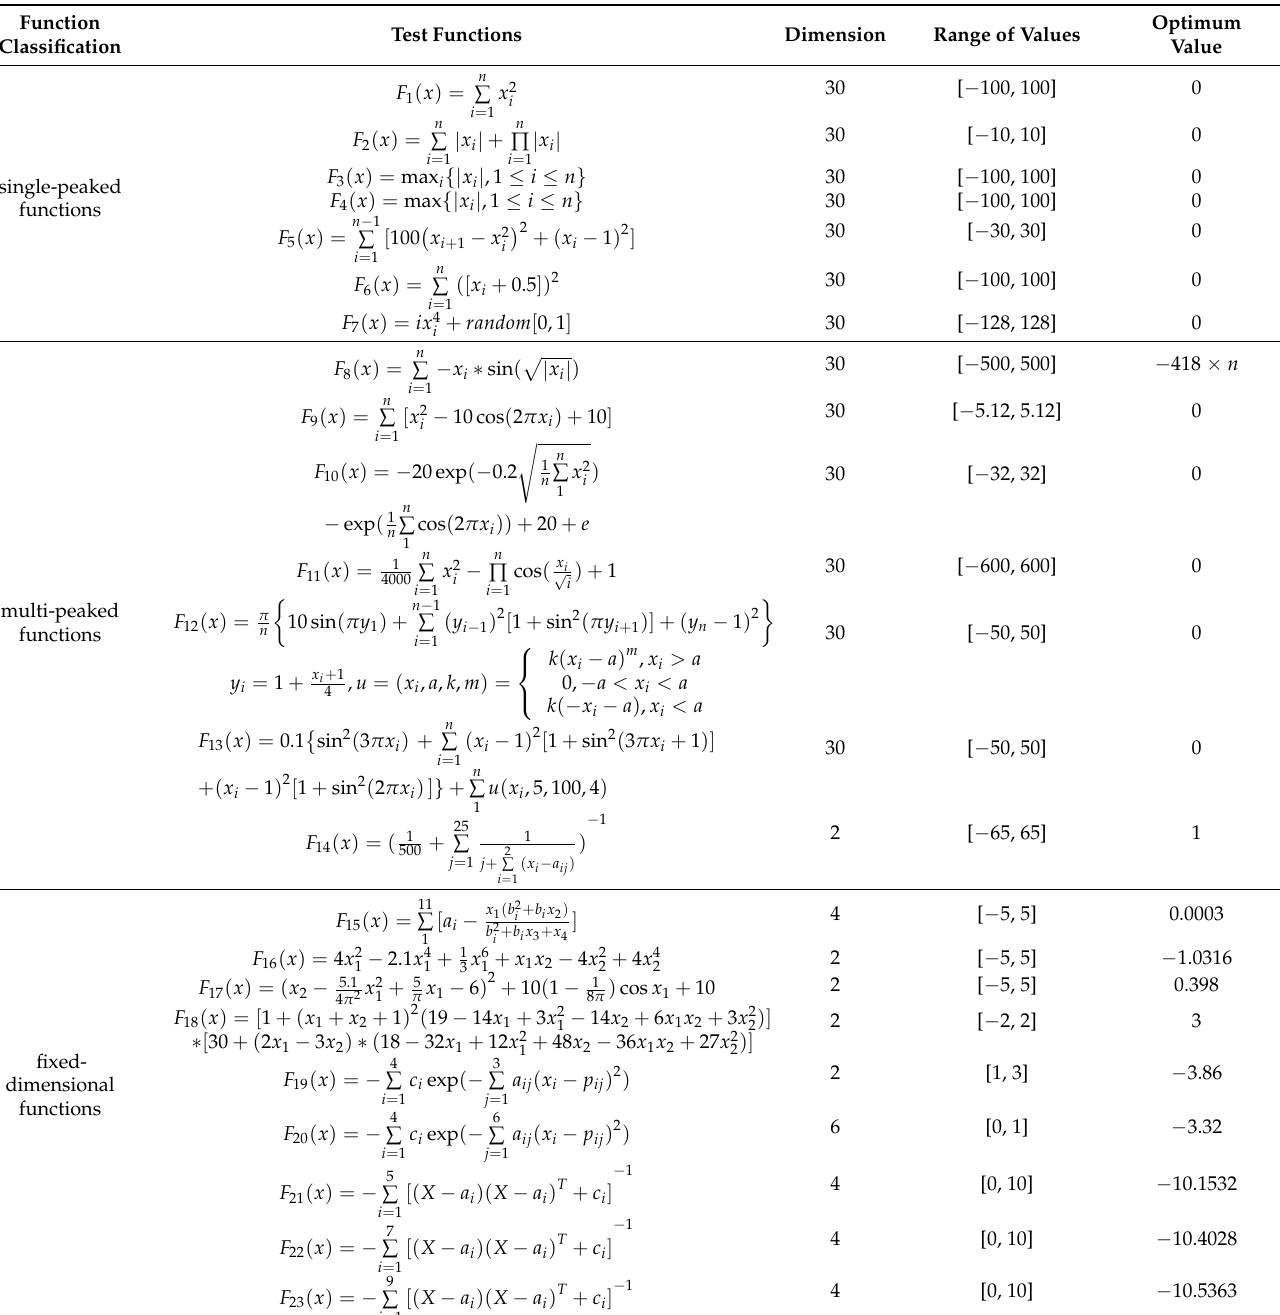
Table 1. Test function